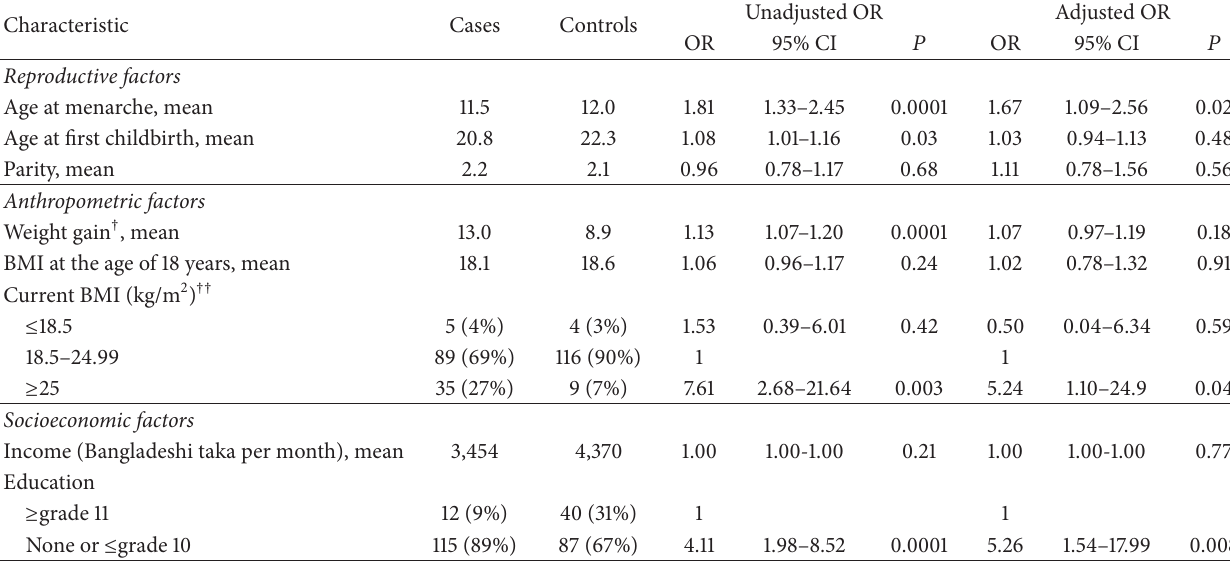
Table 2: Conditional logistic regression analysis to estimate the odds (odds ratios, OR) of breast